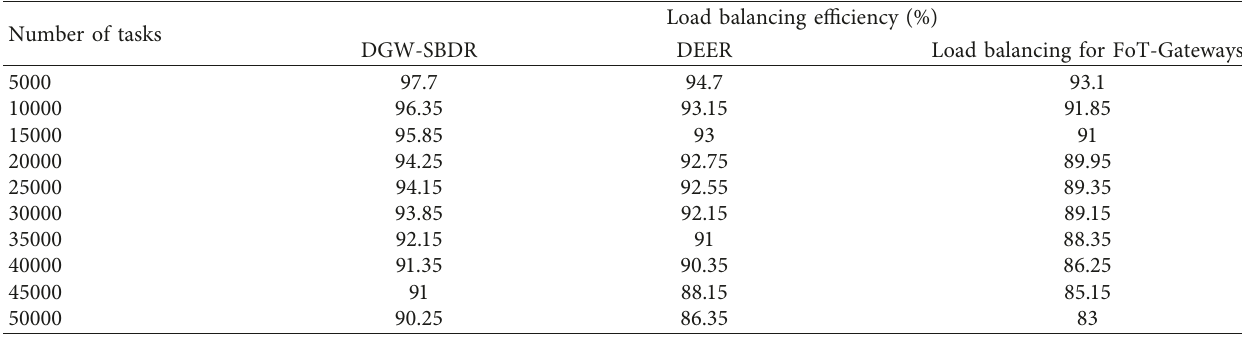
Table 3: Simulation results for load balancing